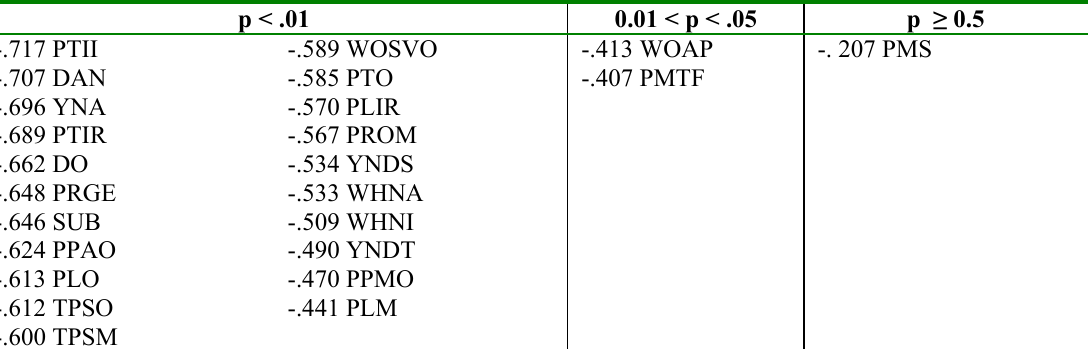
The Correlations between AoAs and Test Scores on Sub-rule Divisions